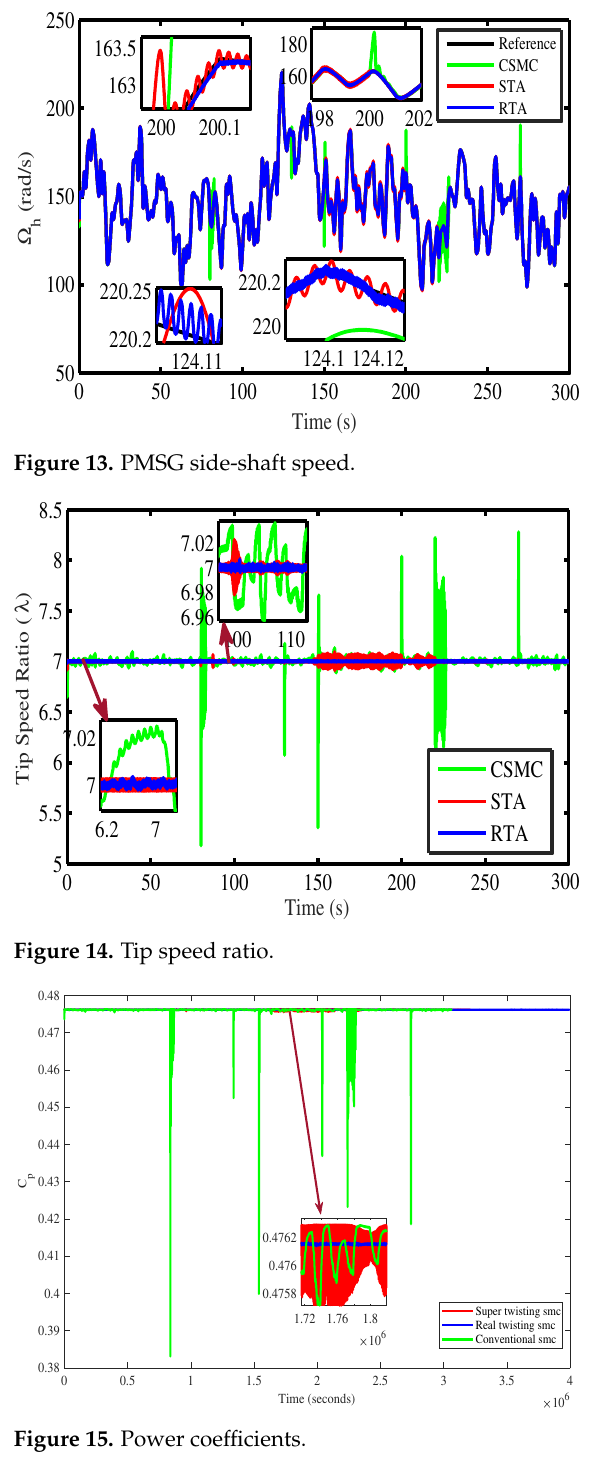
Figure 15. Power